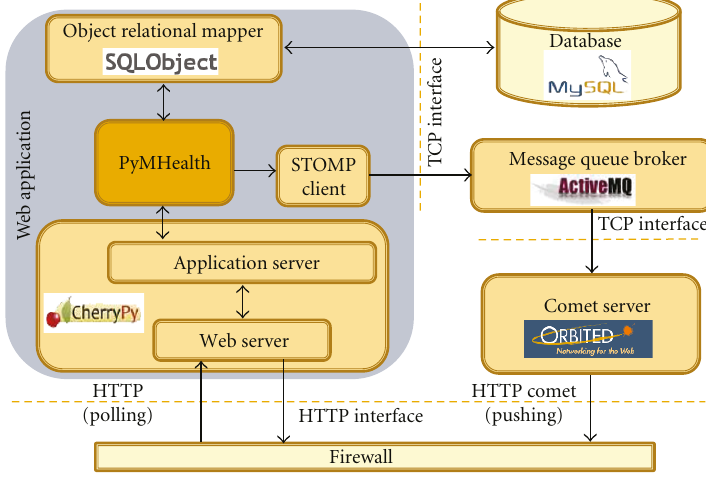
Figure 3: CCS server